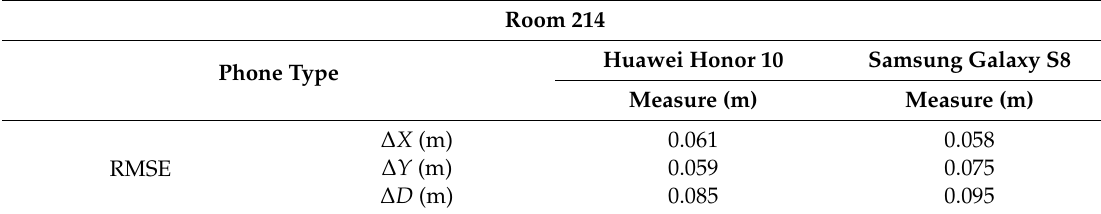
Table 4. Accuracy evaluation of positioning results in Room